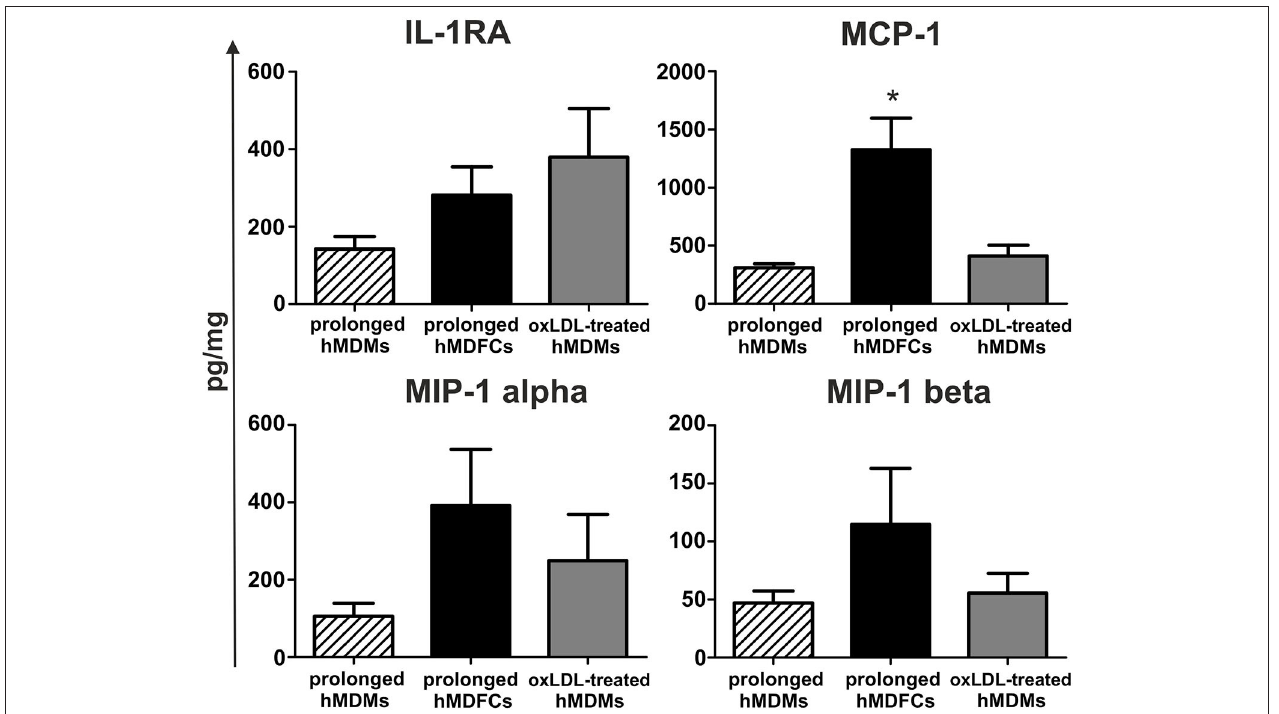
FIGURE 4 | Spontaneous secretion of proteins by prolonged-hMDFCs. Prolonged- hMDMs and hMDFCs were obtained as indicated in Materials and Methods, and Figure 1 . The cells were then incubated for 24h in RPMI 1640 with 2% HS (prolonged-hMDMs) or RPMI 1640 with 2% HS, additionally supplemented with 5 µ g/mL oxLDLs (prolonged-hMDFCs, oxLDL-treated-hMDMs). Levels of cytokines in supernatants were determined by a multiplex immunoassay. Values were normalized to protein concentration in corresponding cell cultures. Data represents production of cytokines secreted consistently at the measurable level. Bars and error bars depict means ± SD of at least three independent experiments (each in triplicate, n ≥ 9). * p <